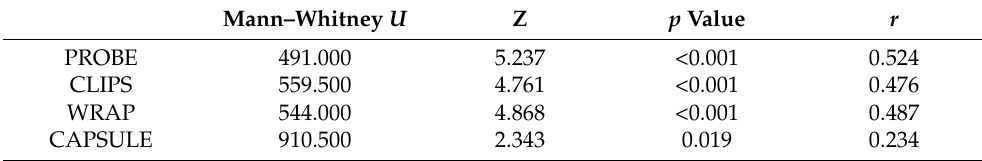
Table 3. Comparison of the resistivity of each pedicle screw according to the measuring method.